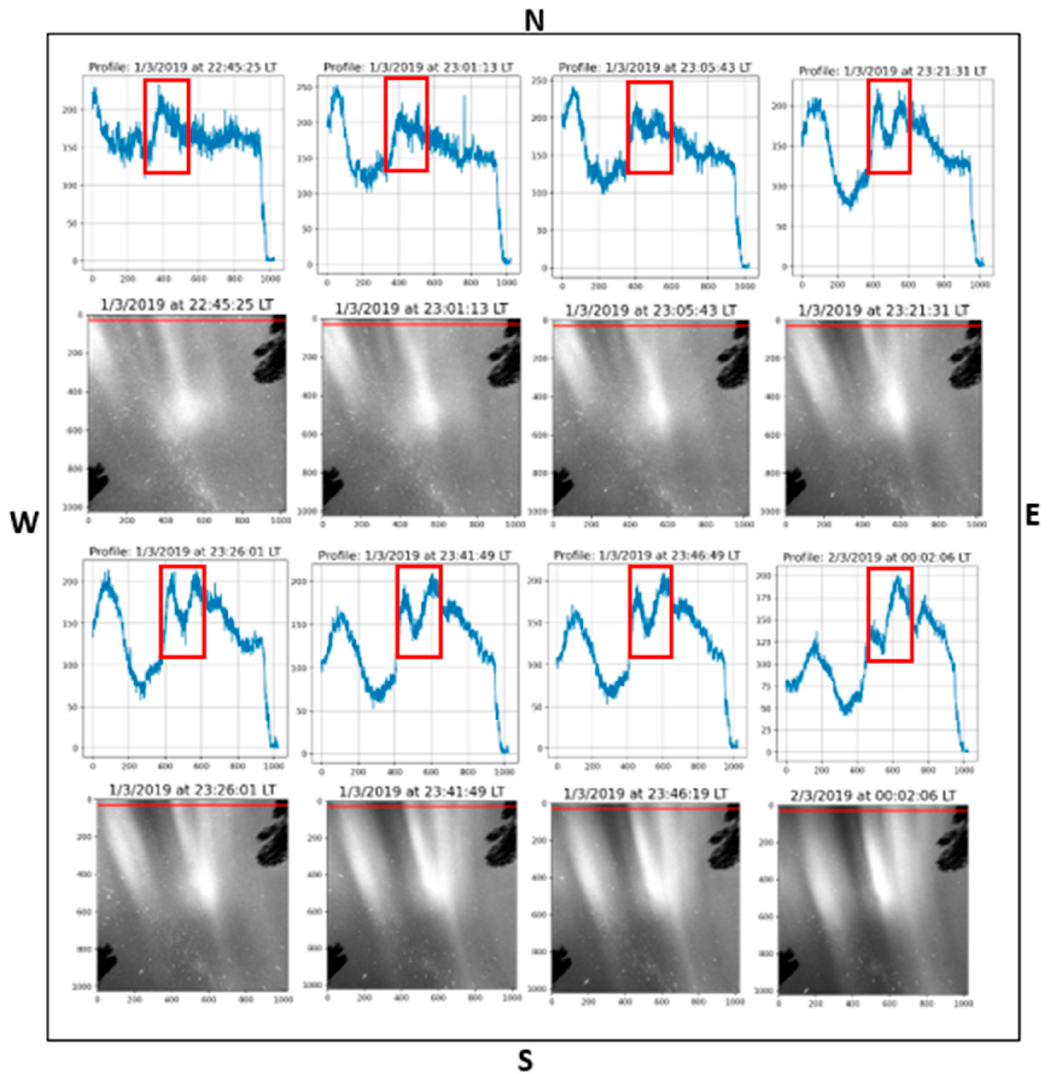
Figure 9. Blob’s bifurcation line profile analysis. A line is placed close to the view’s northern edge to monitor the bubble mapping’s emergence along the field line. The red box indicates the region of the bifurcation of the blob by the bubble. Unwarped images corresponding to a mapped area of the processed image of 1024 km × 1024 km at the OI 630 nm airglow layer, assuming an emission altitude of 250 km.